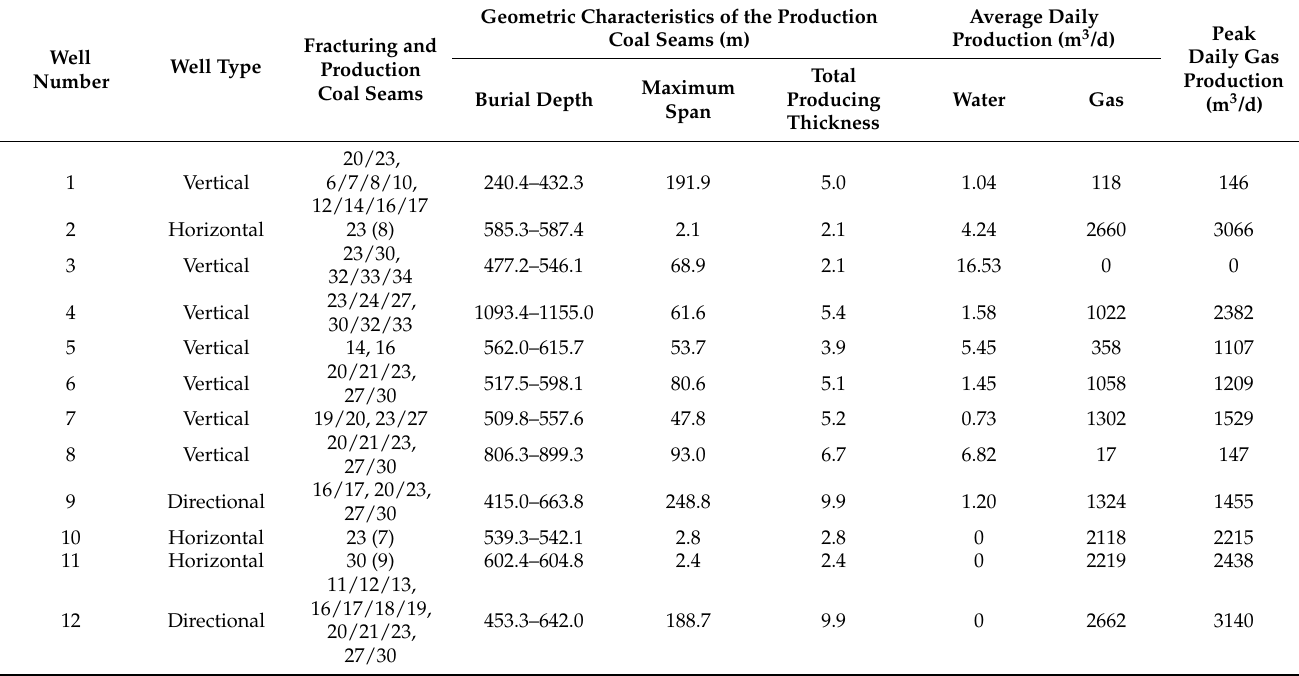
Table 1. Information on the CBM wells.